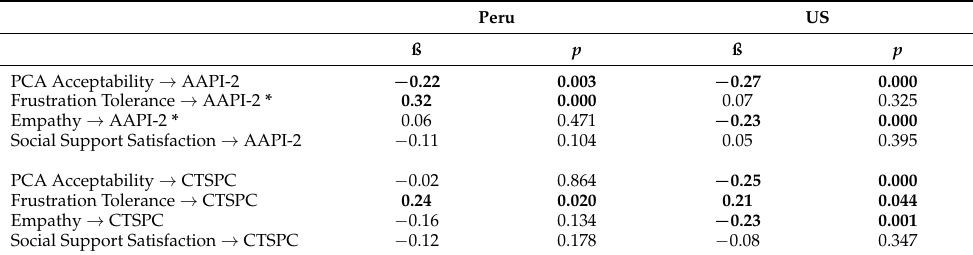
Table 3. Standardized path coefficients by